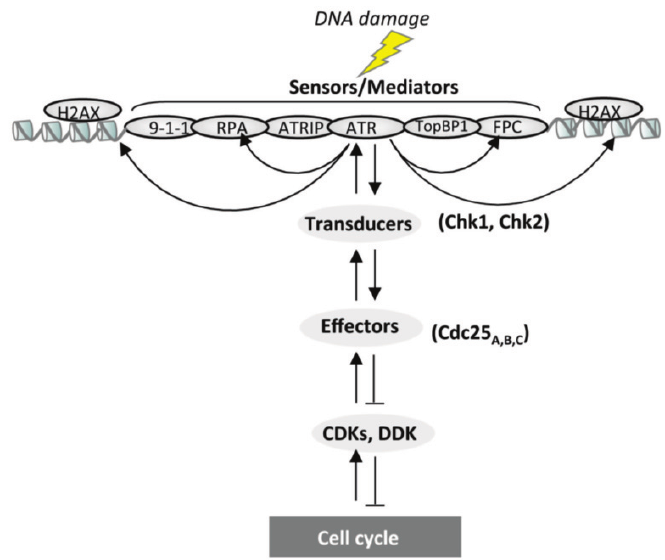
Figure 2. Schematic representation of the replication checkpoint pathway activated following DNA damage. DNA damage generated onto the DNA induces activation and/or relocalization of sensor and mediator proteins triggering a phosphorylation cascade (downwards arrows) that in turn activates soluble, as well as chromatin-bound, transducers and effector proteins resulting in cell cycle delay. Once the damage has been repaired signaling is inactivated by dephosphorylation (backwards arrows). FPC stands for Fork Protection Complex and includes Timeless, Claspin and Tipin proteins.